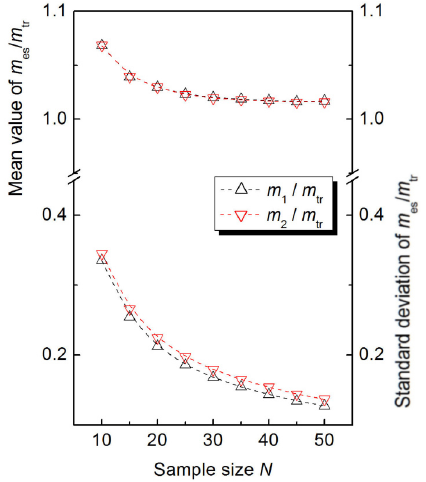
Fig. 5 Variations of the mean value and the standard / m m estimated with the conventional LS deviation of es tr m . method with the prescribed tr